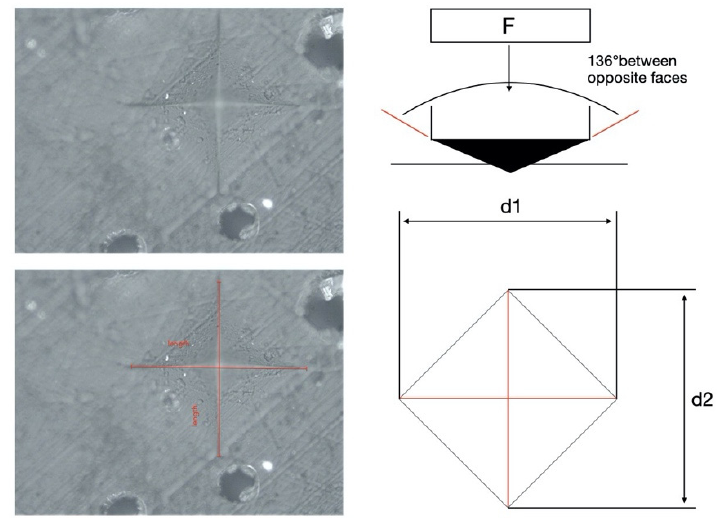
Figure 2. Vickers microhardness test .